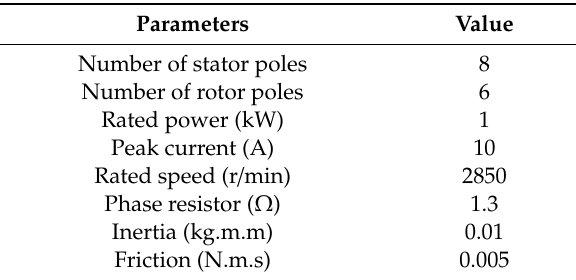
Table 2. Characteristics of the